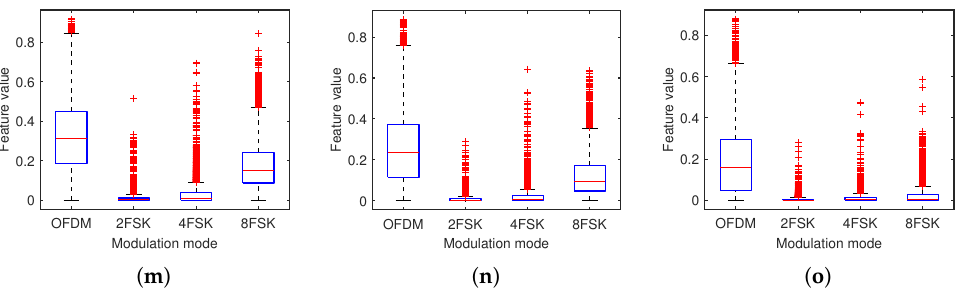
Figure 11. Distribution of 15 extracted features under different modulation modes. ( a ) The second local maximum of OFDM, ( b ) the second local maximum of 2FSK, ( c ) the third local maximum of 2FSK, ( d ) the second local maximum of 4FSK, ( e ) the third local maximum of 4FSK, ( f ) the fourth local maximum of 4FSK, ( g ) the fifth local maximum of 4FSK, ( h ) the second local maximum of 8FSK, ( i ) the third local maximum of 8FSK, ( j ) the fourth local maximum of 8FSK, ( k ) the fifth local maximum of 8FSK, ( l ) the sixth local maximum of 8FSK, ( m ) the seventh local maximum of 8FSK, ( n ) the eighth local maximum of 8FSK, and ( o ) the ninth local maximum of 8FSK.